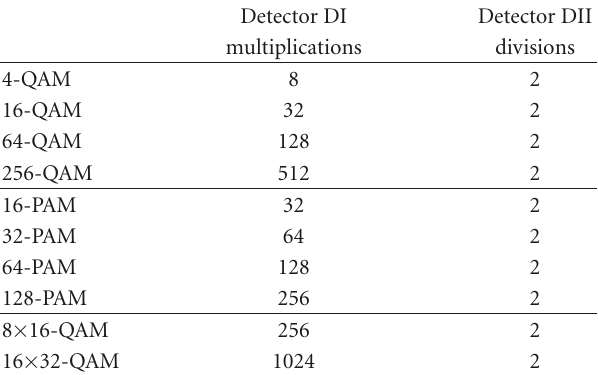
Table 2: Number of real operations required by detector DII to obtain the estimate - s ( t ) of the transmitted symbol s ( t ) based on the noisy observation r ( t ) considering M = 4. Operation Number division 2 subtraction 8 modulus 4 comparison 3 Table 3: Number of real multiplications required by detector DI and the number of real divisions required by detector DII to obtain the estimate - s ( t ) of the transmitted symbol s ( t ) based on the noisy observation r ( t ) as a function of M . Detector DI Detector DII multiplications